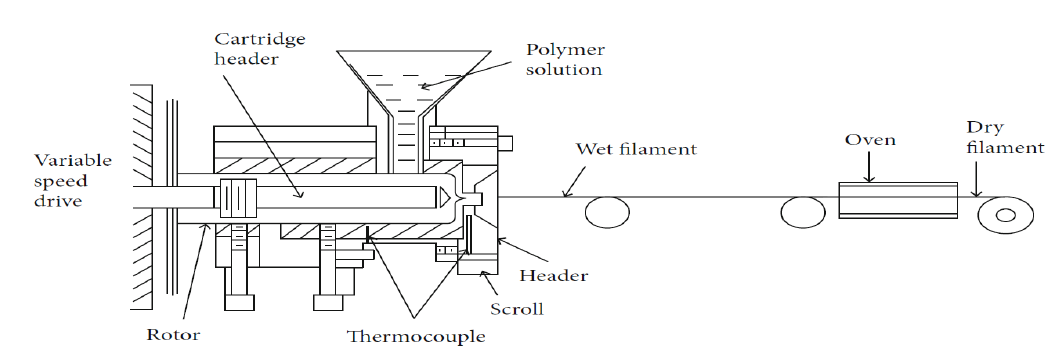
Figure 2. Schematic representation of filament extrusion. Adapted from